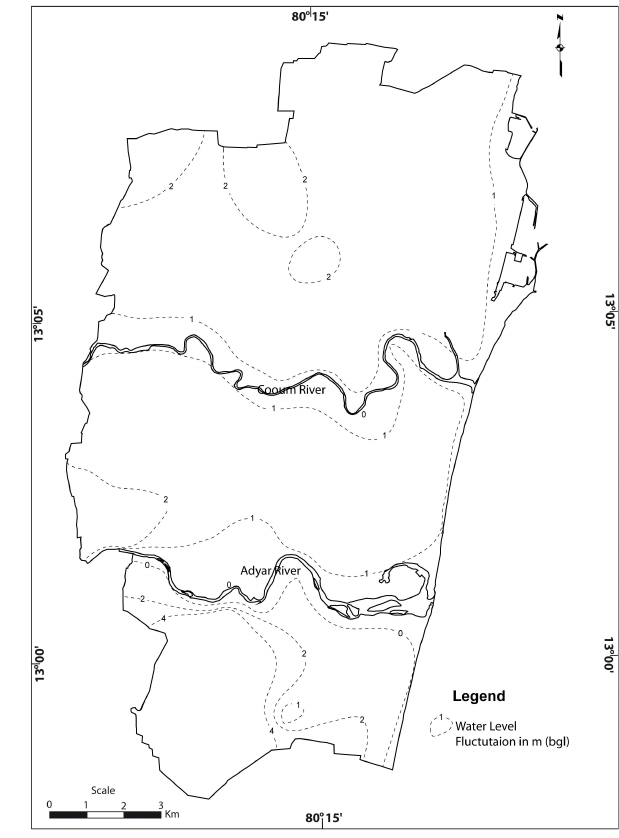
Fig. 6. Map showing the depth to basement of rock at Chennai city. Fig. 7. Map showing the water level fluctuation at Chennai